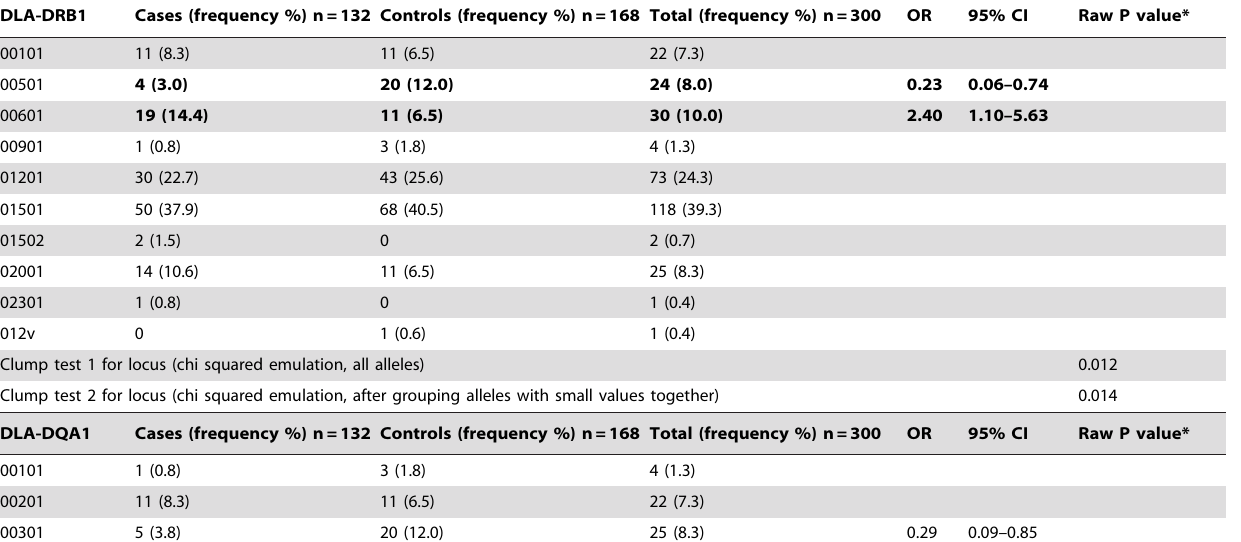
Table 1. Frequencies of DLA class II alleles in 66 ESSs with CH and 84 healthy controls.